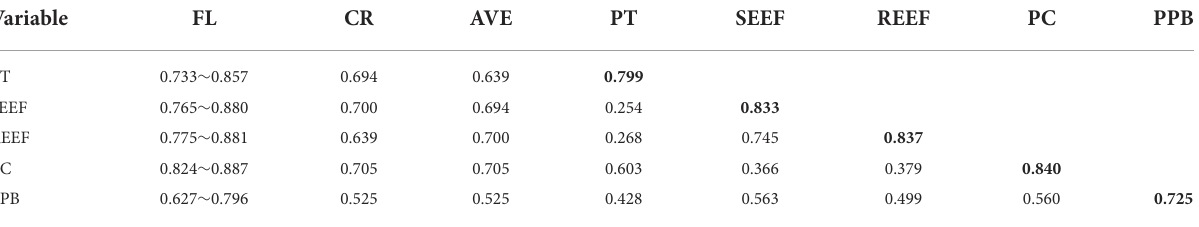
TABLE 2 Reliability, convergent and discriminant validities of the research model.